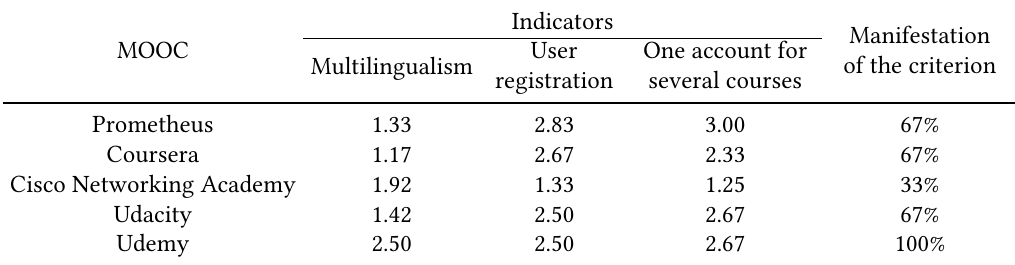
Table 9 Functional criterion of MOOC platforms and its